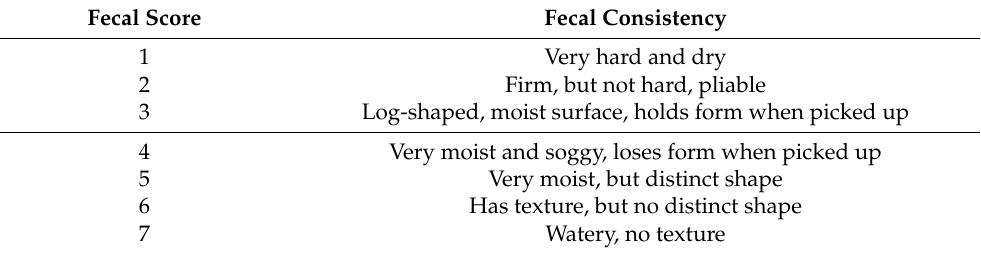
Table 1. Fecal score (Purina fecal score, Nestl é Purina, St. Louis, USA) used to classify fecal samples. Fecal Score Fecal Consistency 1 Very hard and dry 2 Firm, but not hard, pliable 3 Log-shaped, moist surface, holds form when picked up 4 Very moist and soggy, loses form when picked up 5 Very moist, but distinct shape 6 Has texture, but no distinct shape 7 Watery, no